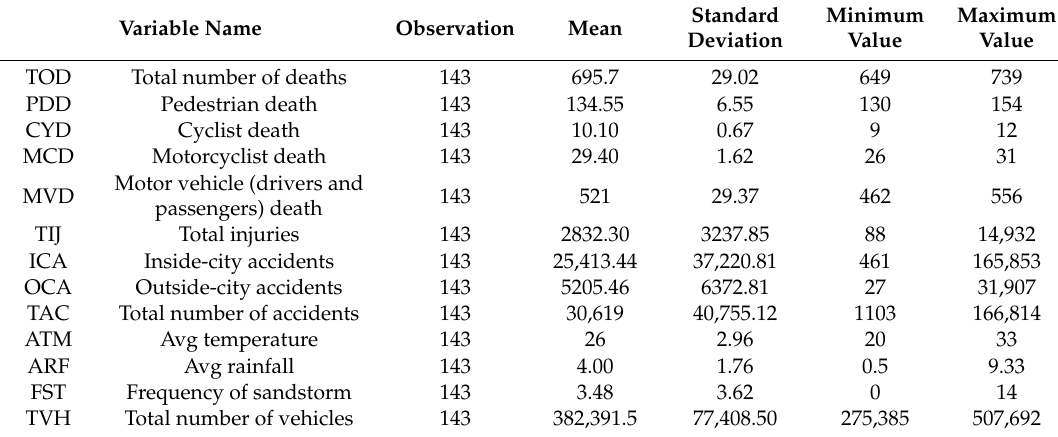
Table 1. Descriptive statistics of the variables a .